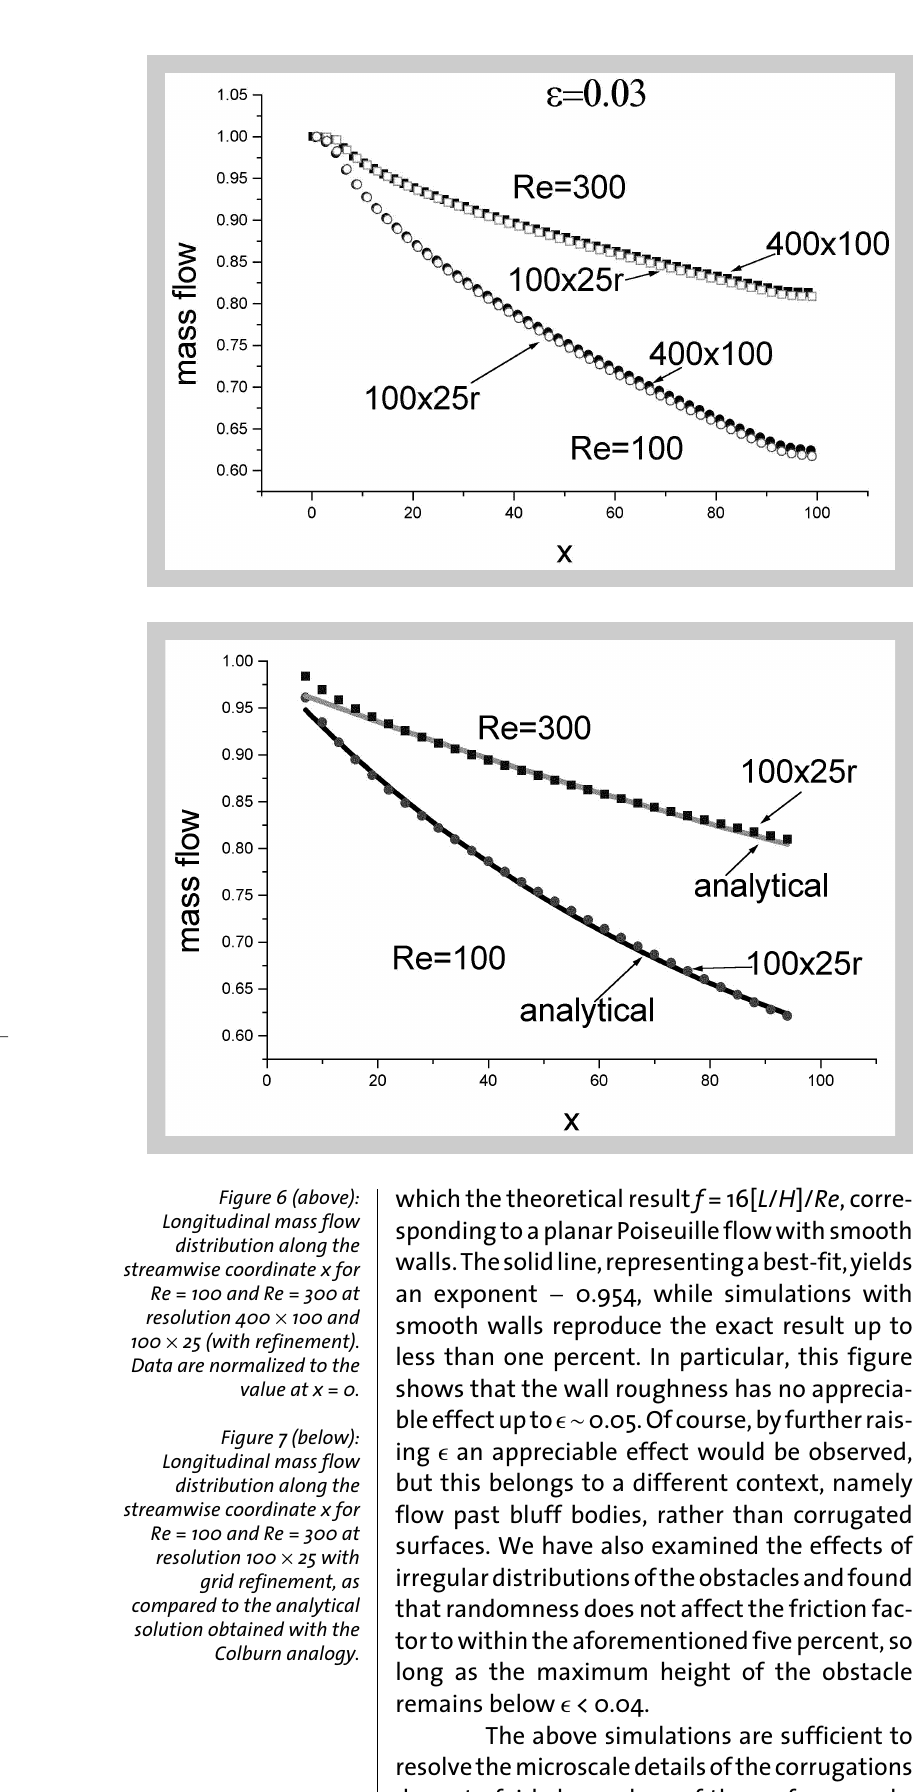
Figure 6 (above): Longitudinal mass flow distribution along the streamwise coordinate x for Re = 100 and Re = 300 at resolution 400 ¥ 100 and 100 ¥ 25 (with refinement). Data are normalized to the value at x = 0. Figure 7 (below): Longitudinal mass flow distribution along the streamwise coordinate x for Re = 100 and Re = 300 at resolution 100 ¥ 25 with grid refinement, as compared to the analytical solution obtained with the Colburn